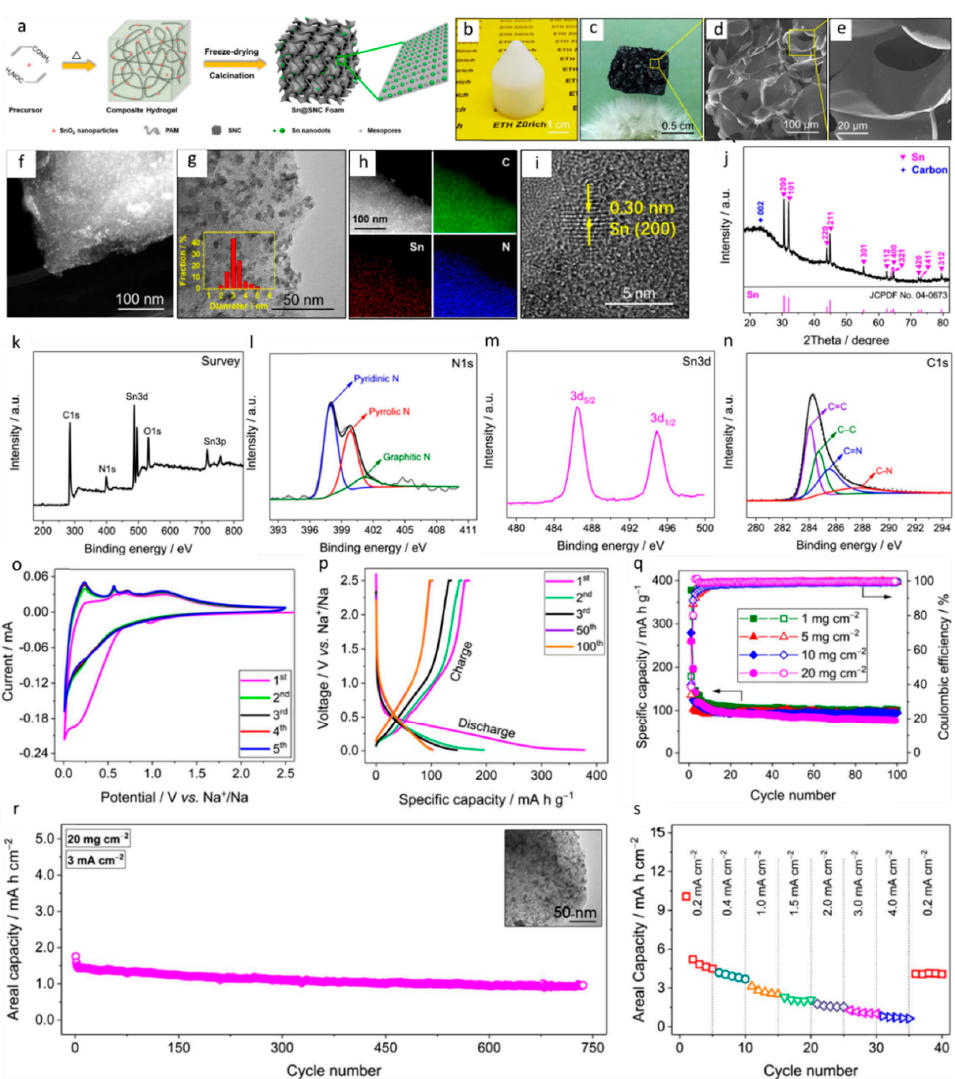
Figure 2. Structural characterization and electrochemical performance analysis of Sn-based alloy